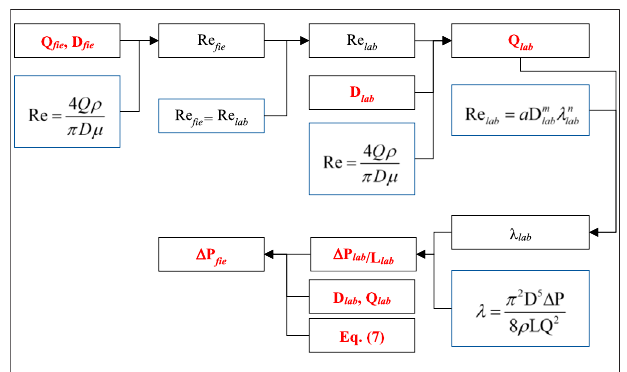
FIGURE 1 | Calculation process of Δ P fi e prediction according to Eq. 7